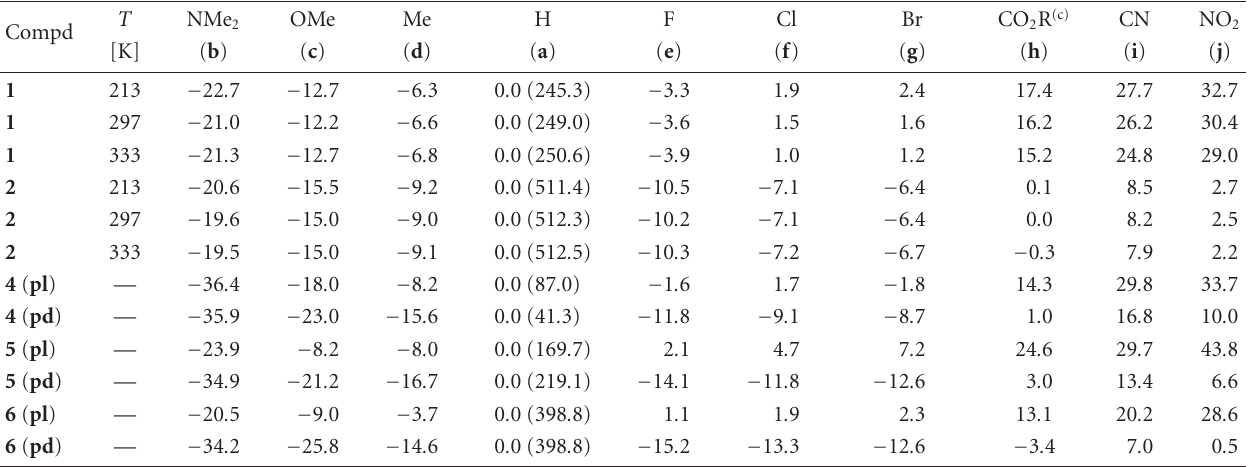
(Se) SCS for 4 – 6 in pl and pd (a,b) . rel